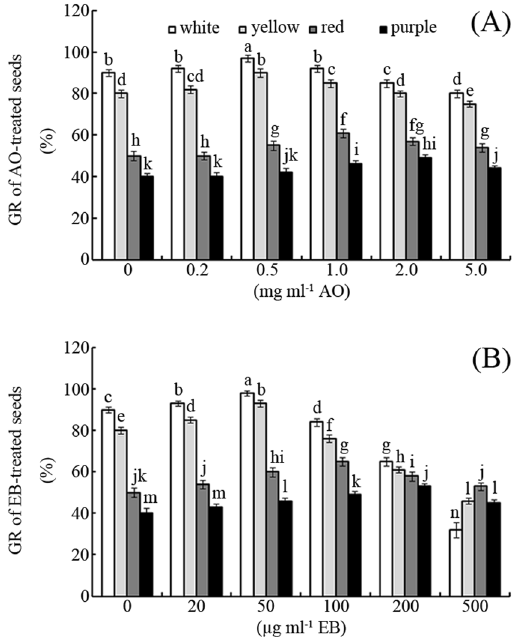
Figure 1. Effects of AO/EB on GR Effects of different concentrations of AO ( A ) and EB ( B ) on the seed GRs of maize. Bars represent standard deviations of means ( n = 5); means followed by the same letter are not significantly different ( p < 0.05) among treatments. EB, ethidium bromide; AO, acridine orange; GR, germination